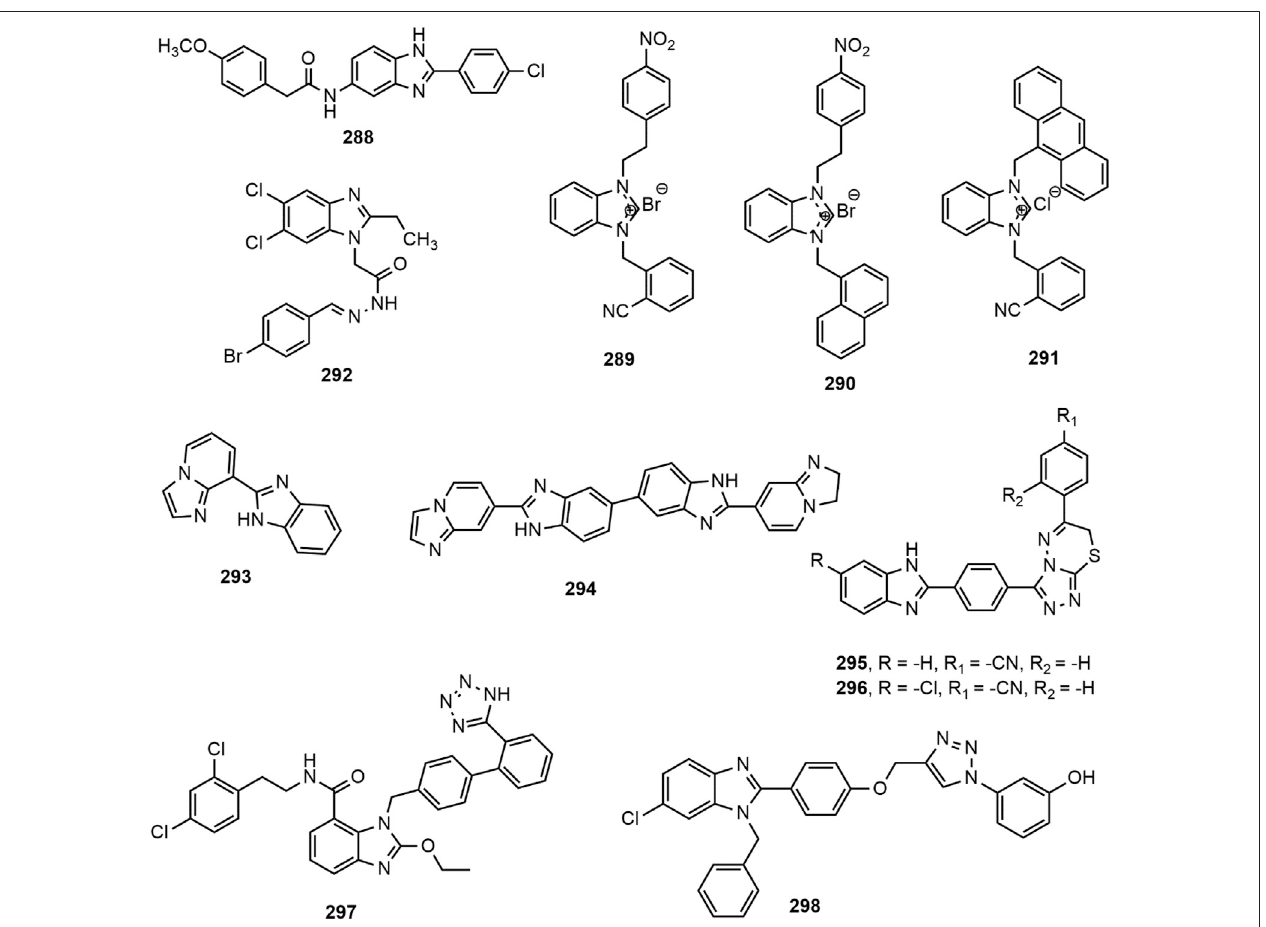
FIGURE 10 | Benzimidazole derivatives with anticancer